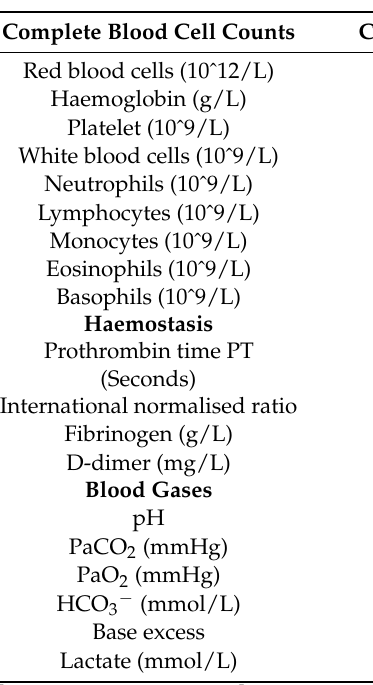
Table 3. Haematology findings at the time of